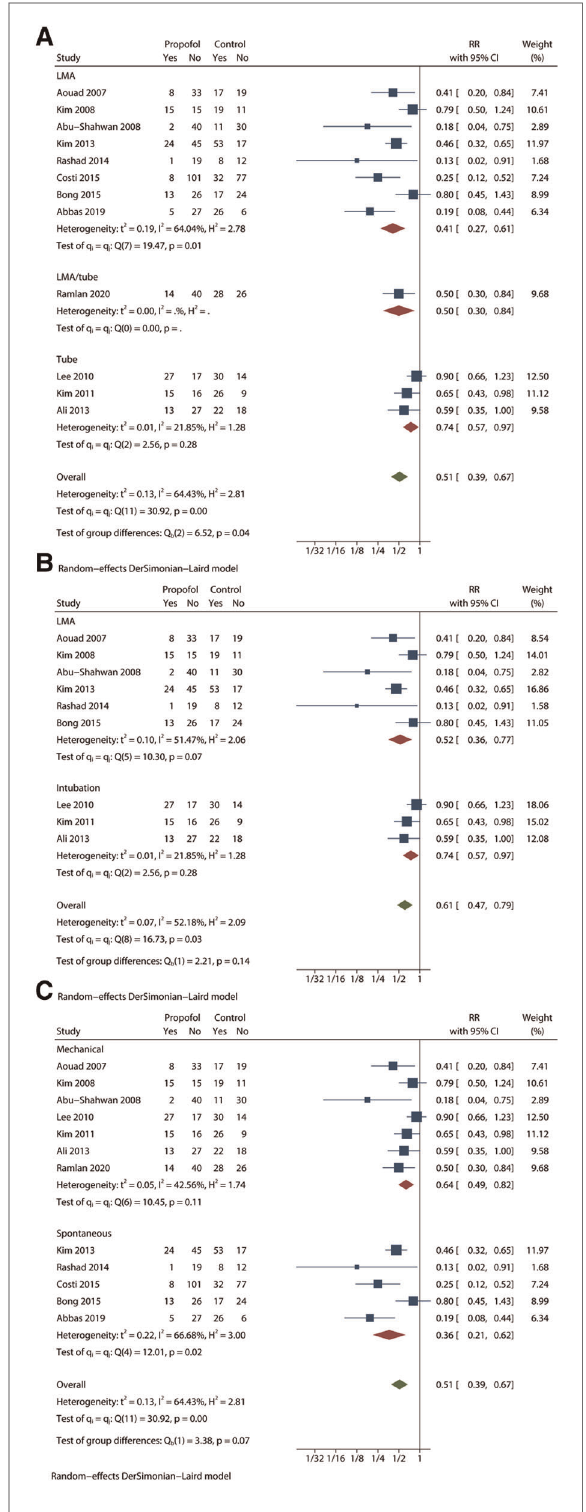
FIGURE 5 Subgroup analysis of EA incidence based on other conditions with meaningful results. ( A ) subgroup forest plot based on airway establishment. ( B ) subgroup forest plot based on airway establishment among studies that used 1 mg/kg propfol. ( C ) subgroup forest plot based on ventilation